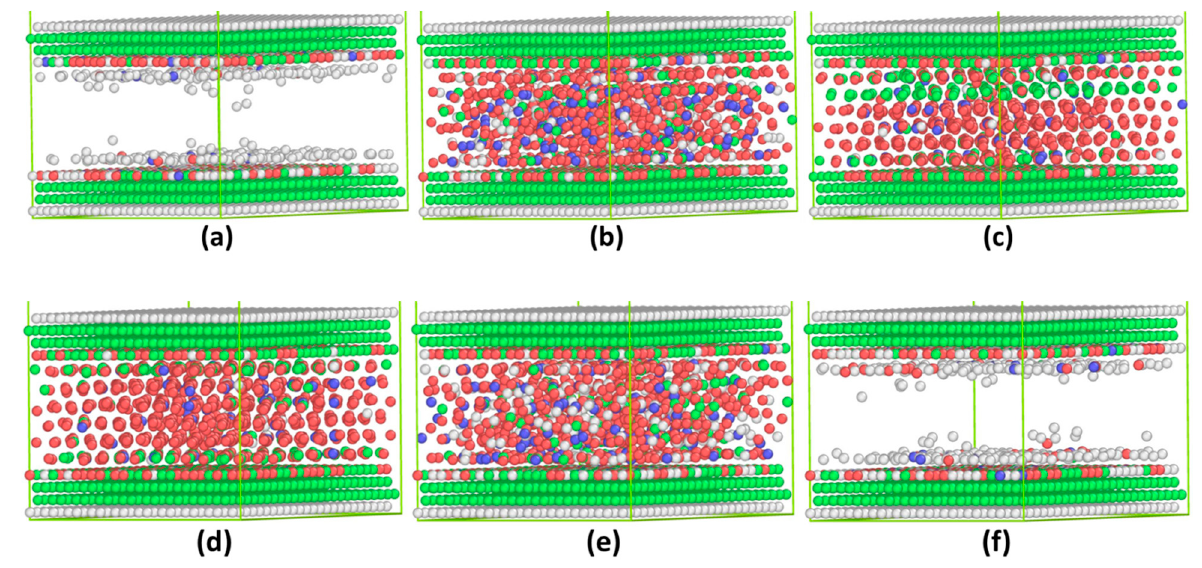
Figure 9. The GCMC snapshots of atomic configurations of adsorption-desorption isotherms for argon molecules confined between two incommensurate contacts at 85 K for n = 6 monolayer thickness. Adsorption: ( a ) µ = − 2.26 kcal/mol, ( b ) µ = − 2.25 kcal/mol, and ( c ) µ = − 2.15 kcal/mol. Desorption: ( d ) µ = − 2.15 kcal/mol, ( e ) µ = − 2.37 kcal/mol, and ( f ) µ = − 2.41 kcal/mol. Table 3. The equilibrium phase in different thicknesses predicted by GCMC simulations with